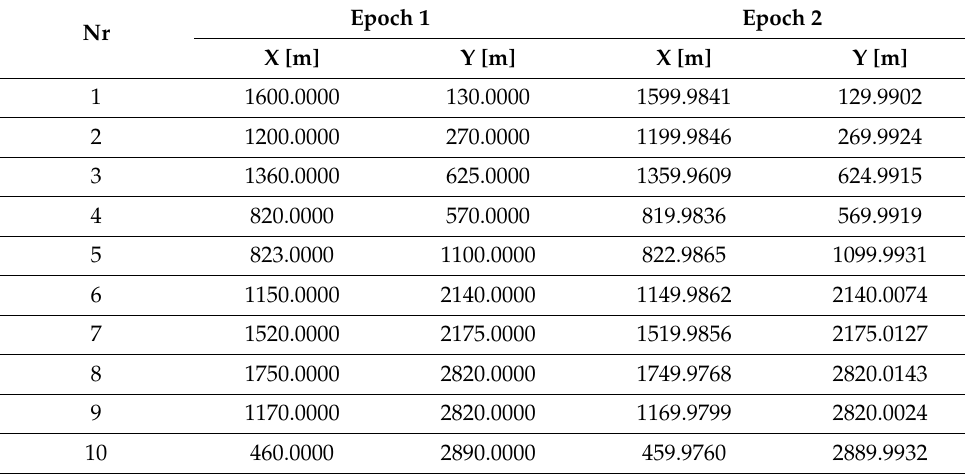
Table 1. Coordinates of points of the test object 1 for both epochs.